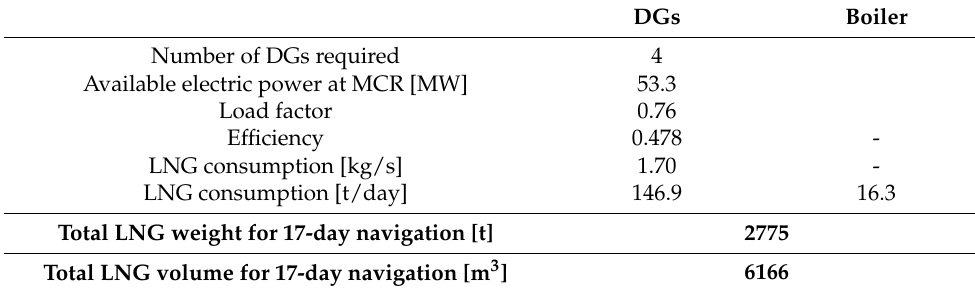
Table 7. Consumption calculations for dual-fuel DGs at cruise speed.